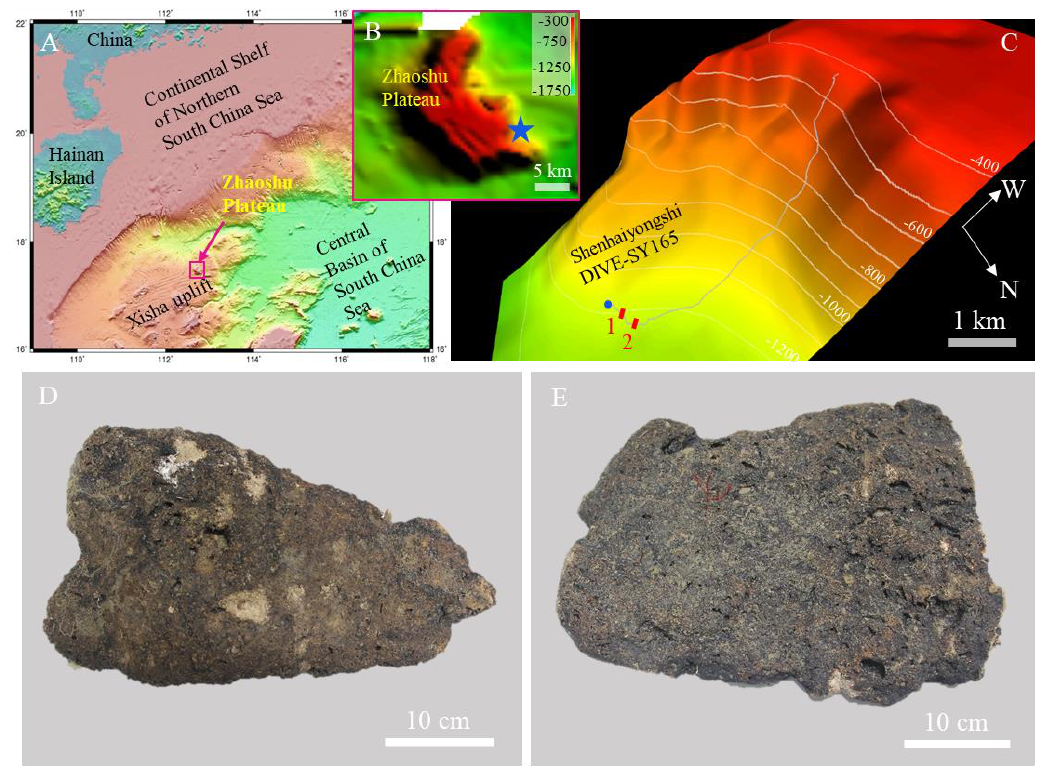
Figure 1. ( A ) Topography of the northern South China Sea and the location of the investigated area, the Zhaoshu plateau. ( B ) Enlarged bathymetry of the location of the Zhaoshu plateau. The blue star in the panel indicates the deployment location of Shenhaiyongshi. ( C ) Dive track on a 3D view of the southeast slope of the Zhaoshu plateau (star in panel B). The blue circular indicates the sampling location, and carbonates developed along to No.1 (shown in Video S1). Carbonate fractures were observed at location No.2 (Video S1). On the way from No. 1 to No. 2, massive sediments were